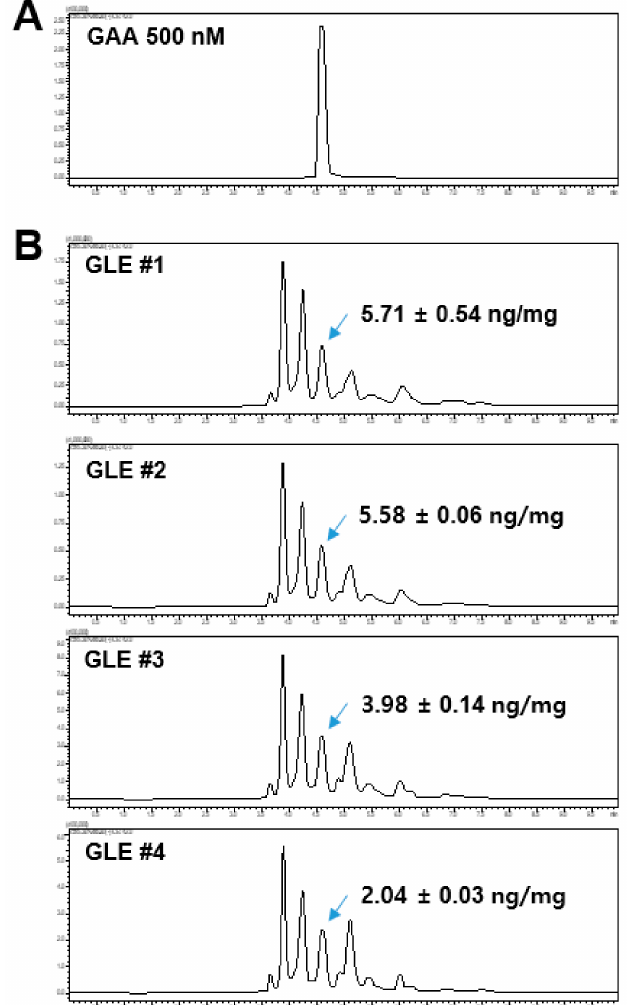
Figure 6. Identification of GAA in GLE. ( A ) LC-MS / MS profile of 500 nM GAA. ( B ) LC-MS / MS profiles of GLE samples. GAA and GLE: Ganoderic acid A and Ganoderma lucidum extracts,